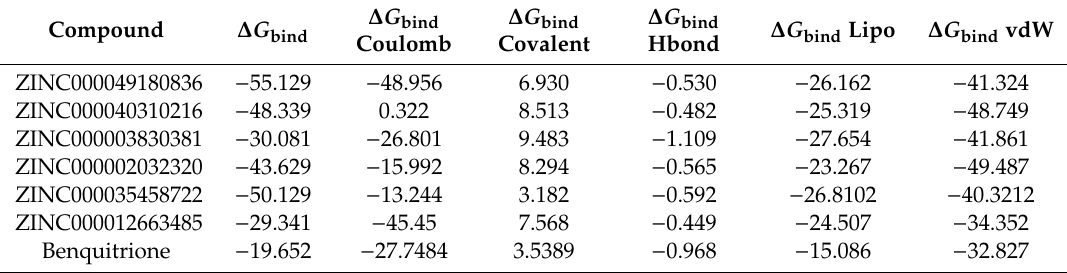
Table 2. Contributions of various energy components to the binding free energy (kcal mol − 1